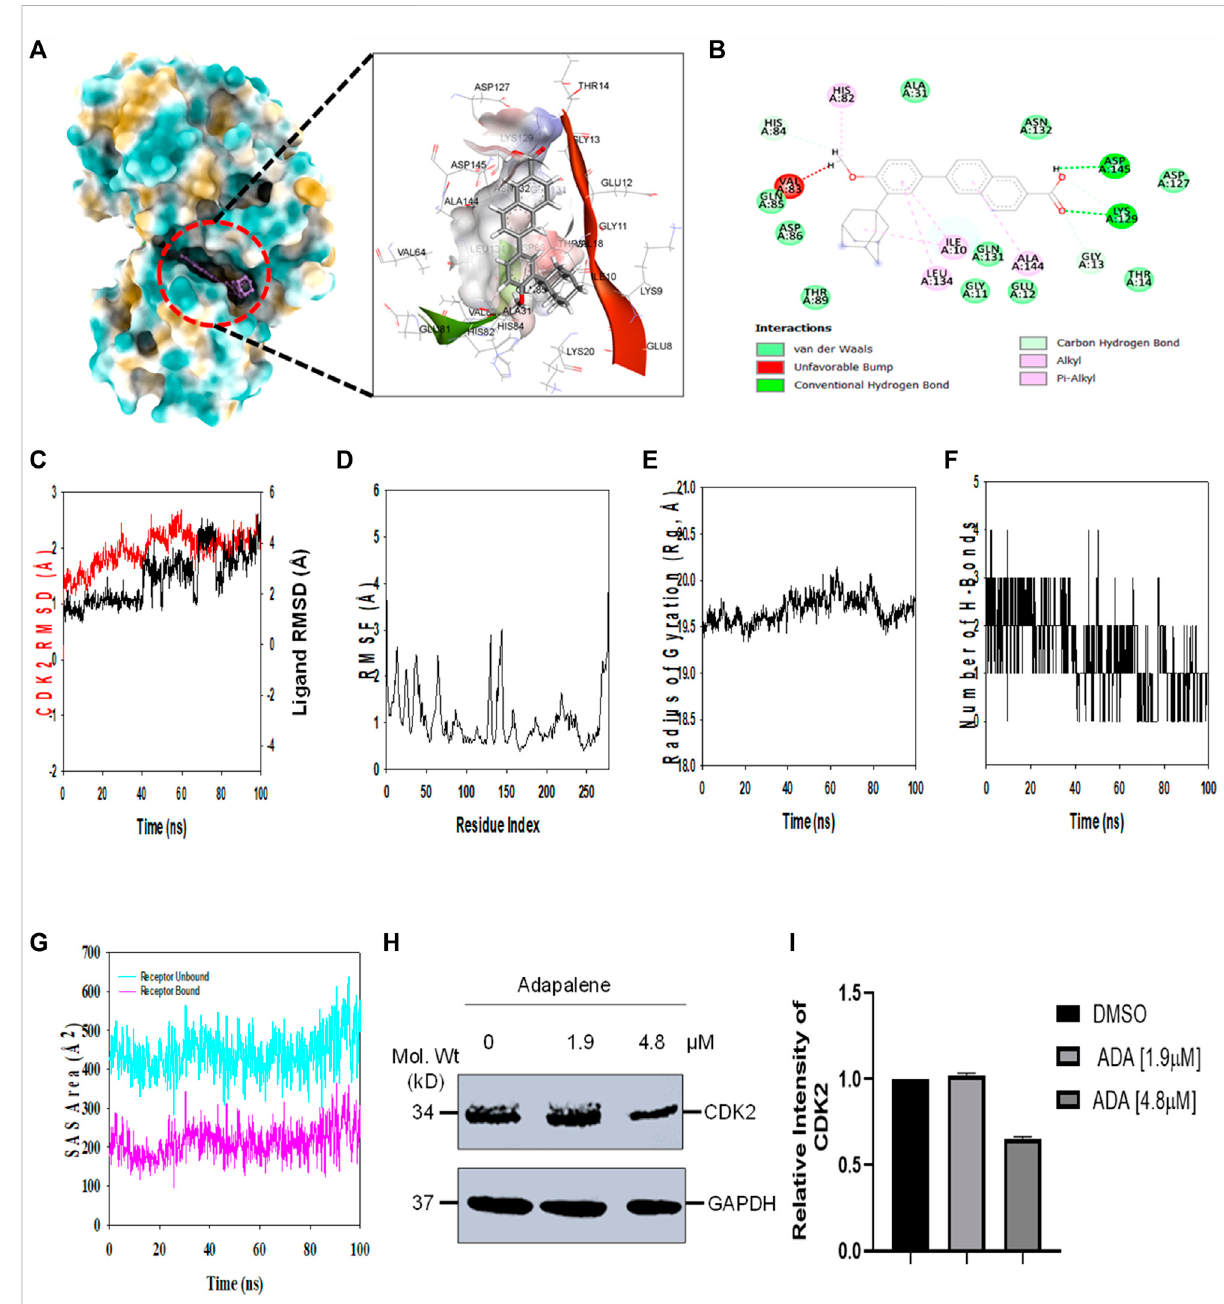
FIGURE 6 ADA shows high binding af fi nity and stability with CDK2 (A) . Analysis of the binding pose of ADA at the binding cavity of CDK2 on the left panel and 3D cavity interaction of residues with ADA (B) . 2D interaction of ADA showing various interactions at the binding cavity of CDK2 (C) . RMSD plot displaying the molecular vibration of C α backbone of CDK2 (red) and ADA (black) (D) . RMSF plot showing the fl uctuations of respective amino acids throughoutthesimulationtime100 nsforCDK2-ADA (E) .TheradiusofthegyrationplottodeducethecompactnessofCDK2boundtoADA (F) . The number of hydrogen bonds formed between CDK2-ADA during the 100 ns simulation time scale (G) . Solvent accessible surface area (SAS Area) displaystheunboundareaatthebindingpocket(cyan)andboundADAwithCDK2 (H) .ImmunoblotofCDK2upontreatmentwithADA.ADAreduced CDK2 in a dose-dependent manner (I) . Relative intensity of CDK2 protein levels upon treatment with